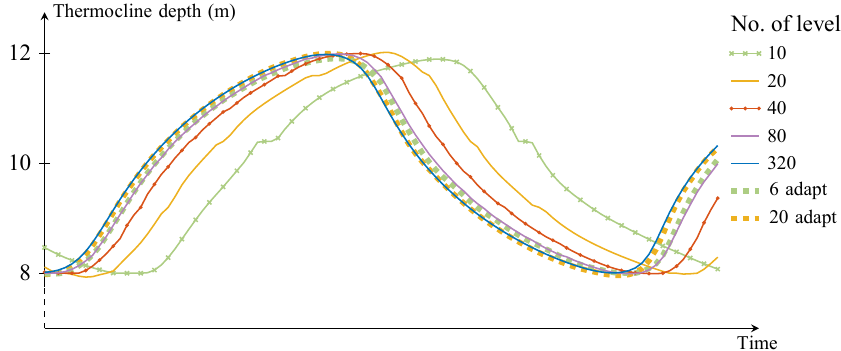
Figure 10. Convergence analysis for the internal seiche modelling. The graph shows the third oscillation of the seiche, at which moment the results are beginning to diverge from the high-resolution solution.